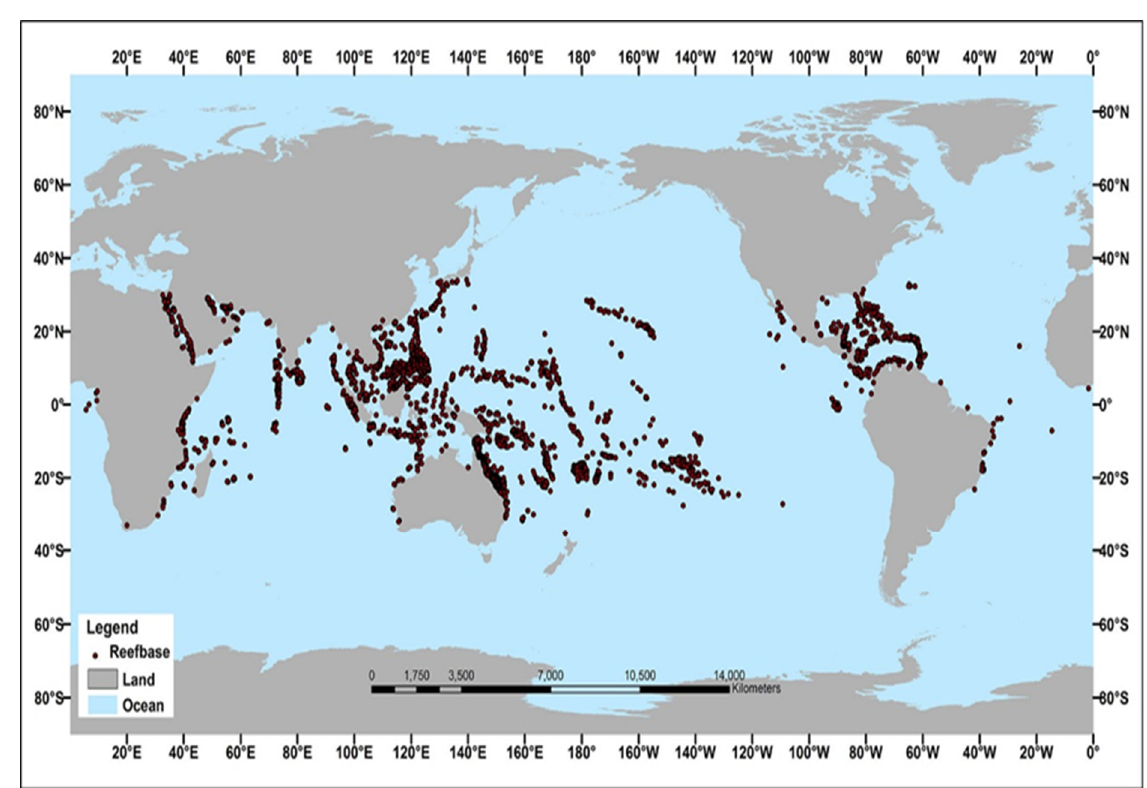
Figure 4. Map of the potential use of this methodology, highlighting the importance of the biofuel production in tropical areas where the energetic crisis will be much harder in future decades (map from NOAA Service of Education).